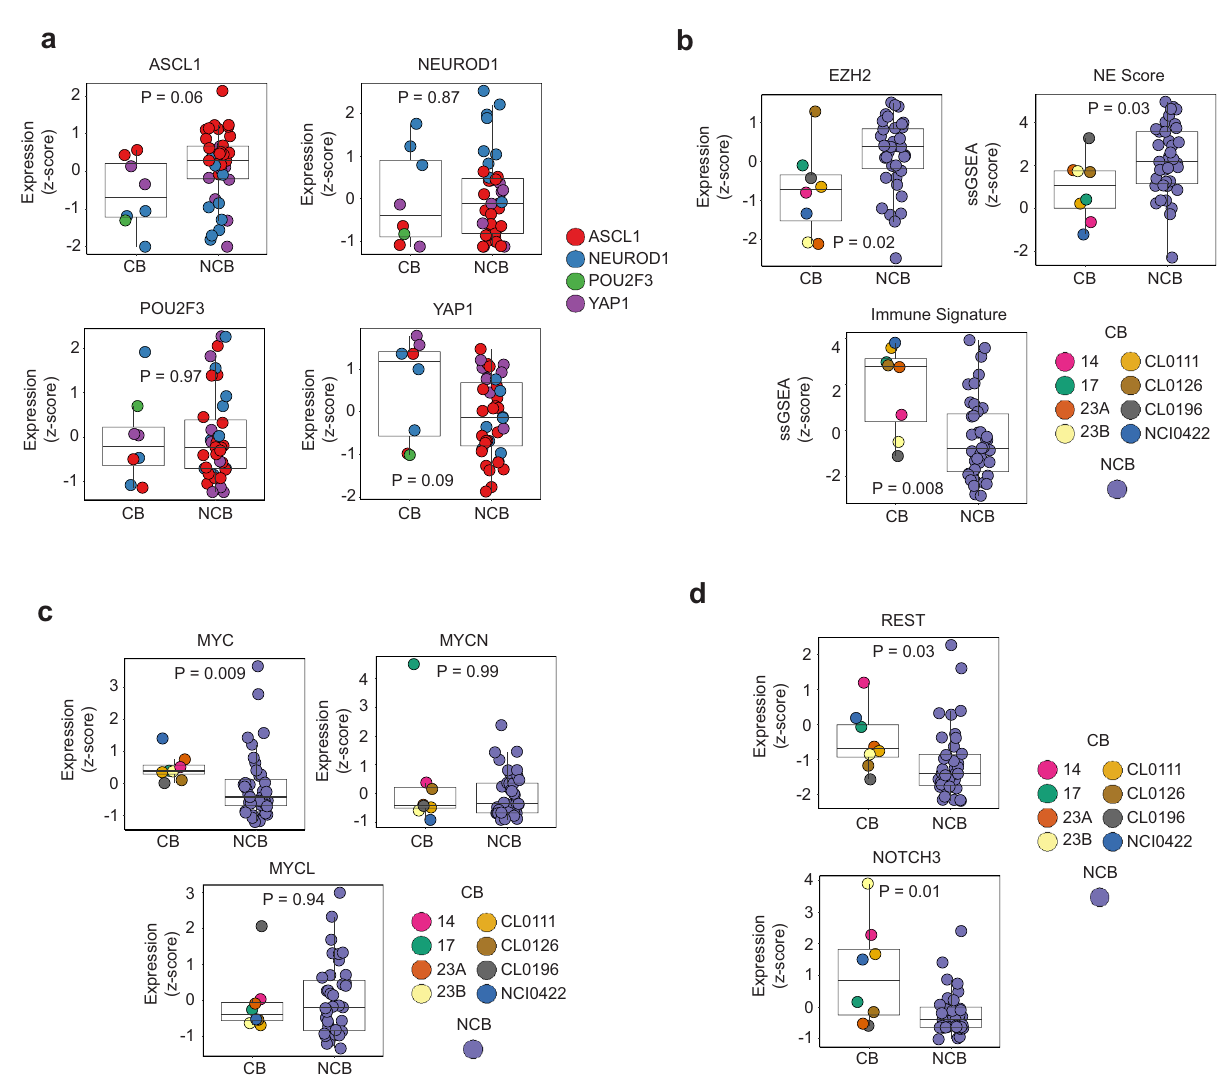
Fig. 4 Variables associated with clinical bene fi t to immune checkpoint blockade across both relapsed small cell lung cancer cohorts. Association between clinical bene fi t to ICB and expression of a transcriptional subtype genes, b EZH2 and ssGSEA NE differentiation and immune signature scores, c MYC family members ( MYC , MYCN and MYCL ) and d established Notch signaling target genes. Statistical signi fi cance was tested with a two-tailed Mann – Whitney U test. Boxplots represent the median, 25th and 75th percentiles and the vertical bars span the 5th to the 95th percentiles. Source data are provided as a Source Data fi